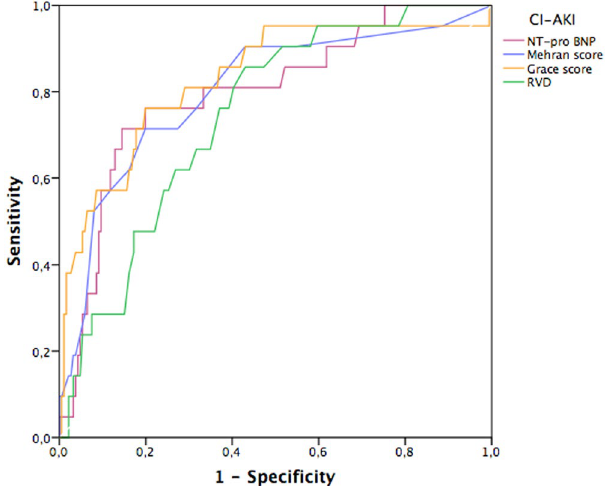
Figure 2. ROC curves comparing sensitivity and specificity of retinal vascular density to the Mehran score, NT- proBNP and GRACE score for the occurrence of contrast-induced AKI.